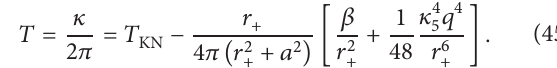
for the conventional KN